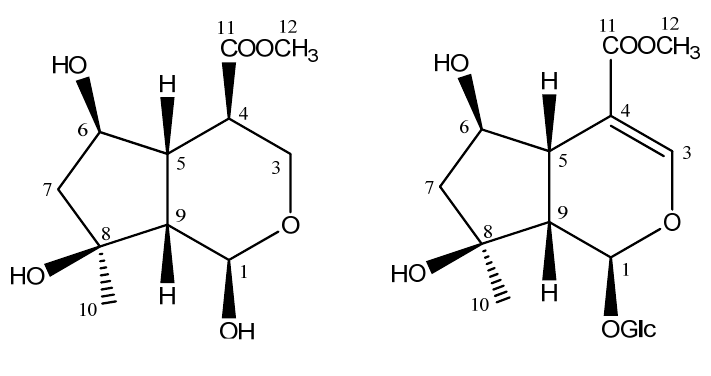
Figure 1. Structures of compounds 1 and 2